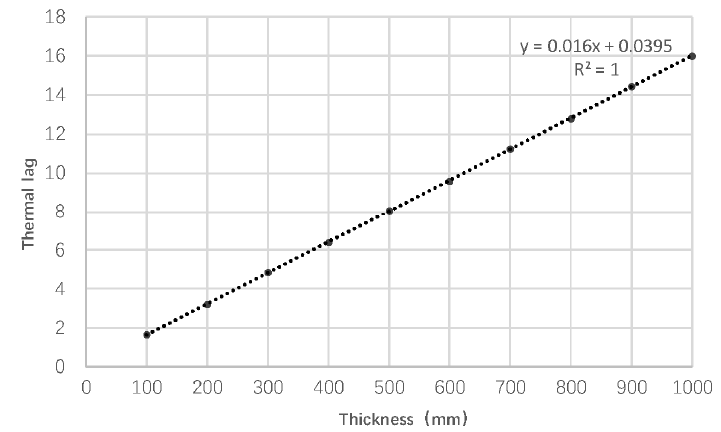
Figure 7. Thickness and thermal lag.